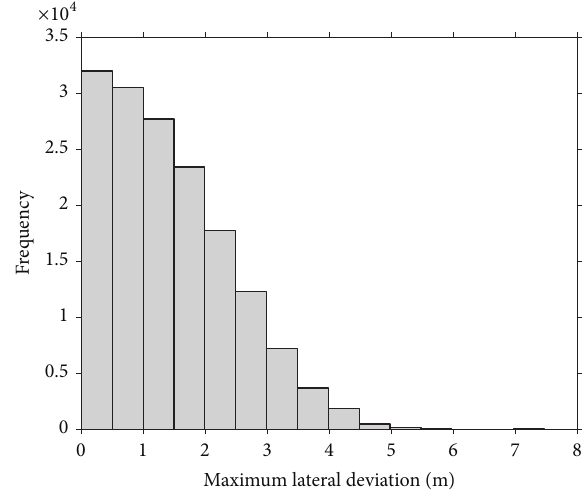
Figure 10: Absolute value of the lateral deviations for all possible test